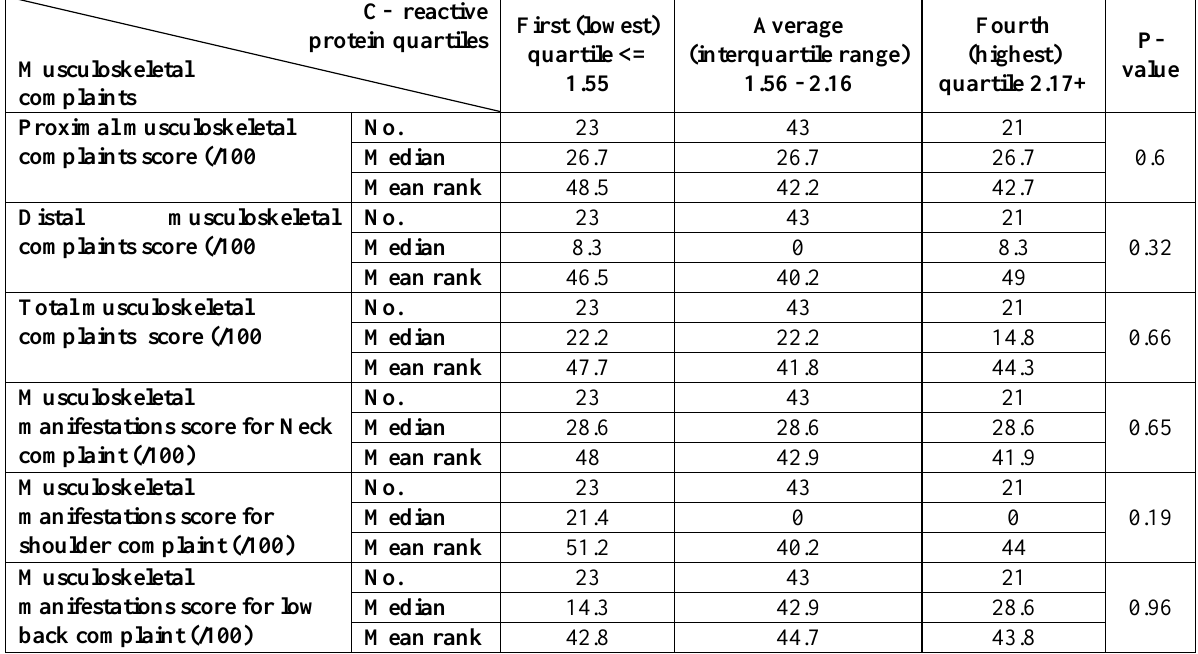
Table 6: musculoskeletal complaints according to Salivary C-RP